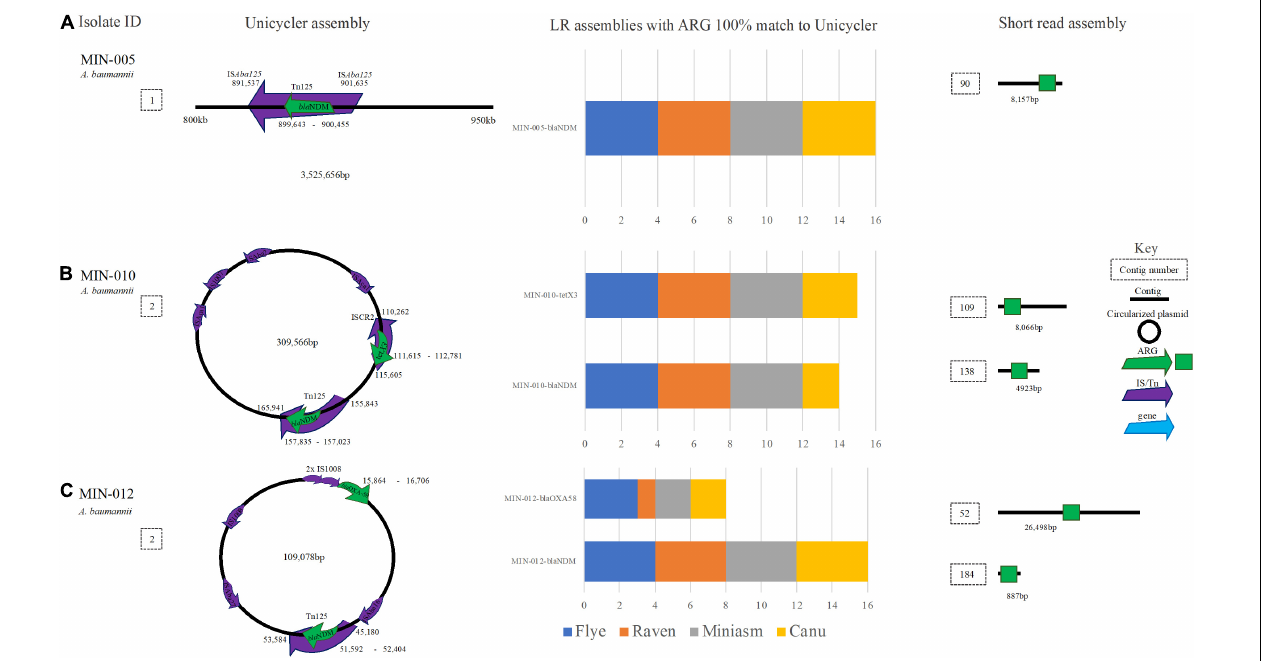
FIGURE 8 | A schematic to compare A baumannii ARG detection from the Unicycler (hybrid) assembly (left), with the short read (SR) assembly (right). The stacked bar graphs (center) denote the number of LR assemblies with a 100% match to the Unicycler assembly (A) MIN-005 with bla NDM located on the chromosome,